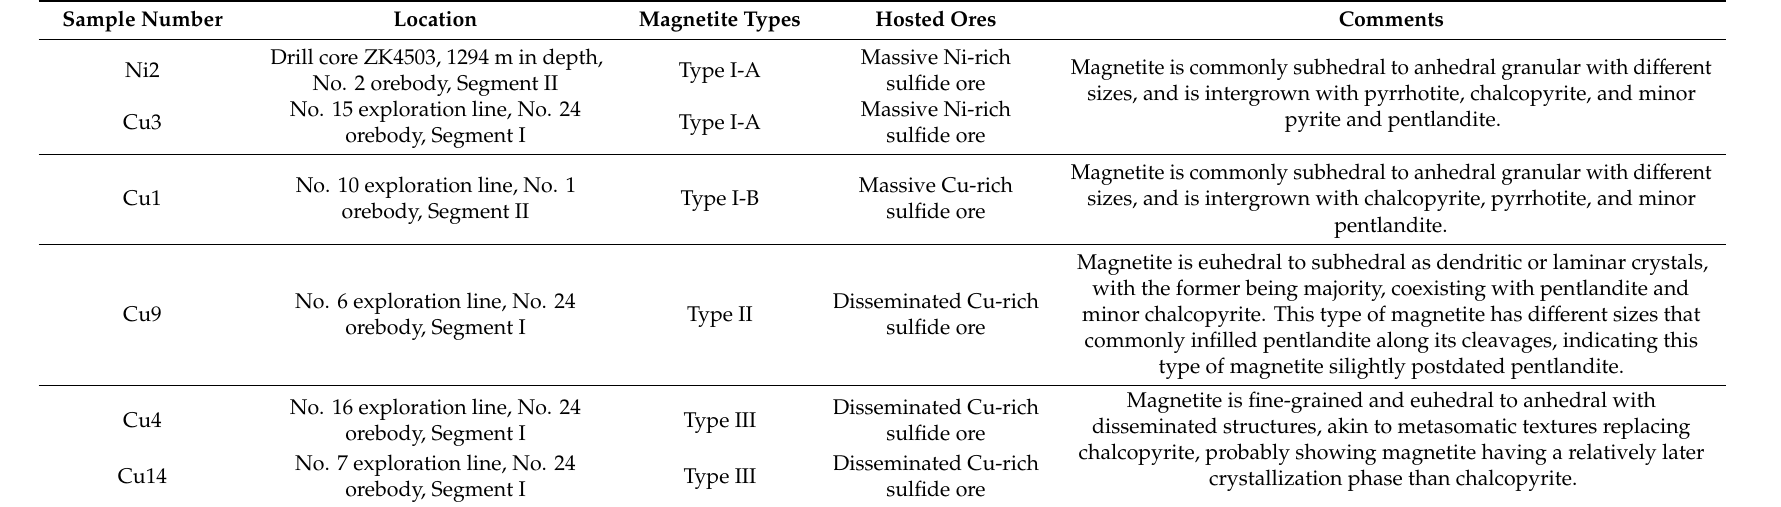
Table 1. Sample description of analyzed di ff erent magnetite types in the Jinchuan Ni-Cu-PGE